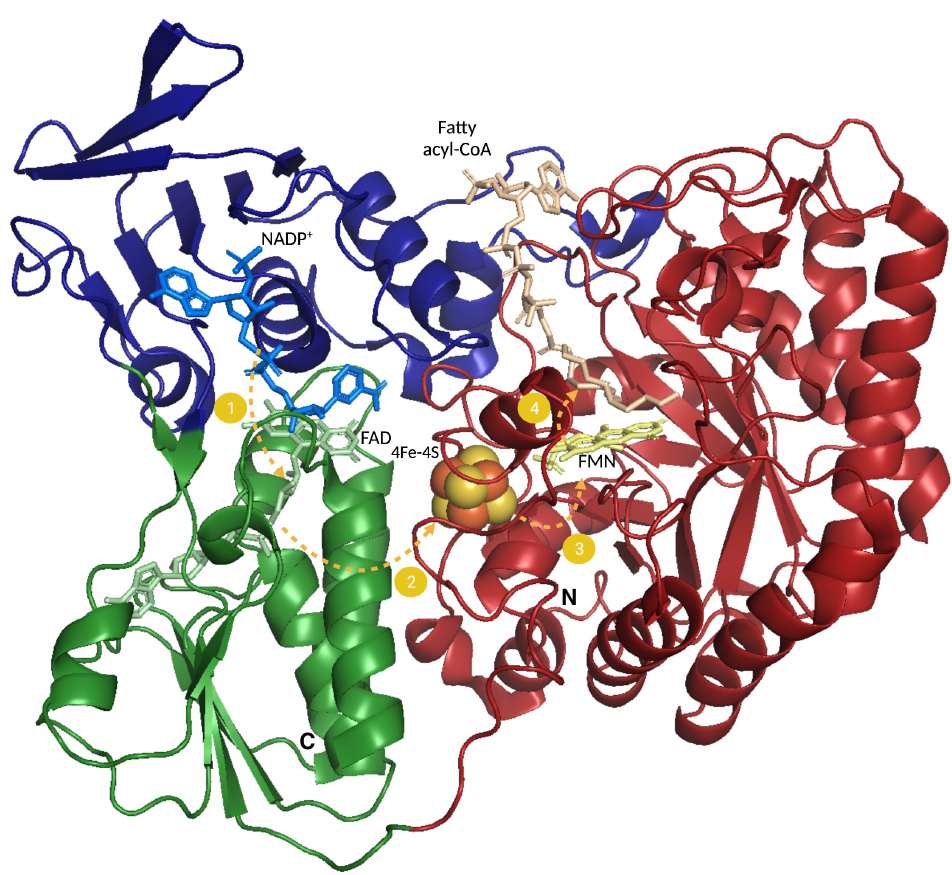
Figure 6. FadH structure. The 3D structure of E. coli FadH determined by X-ray crystallography is shown (PDB code: 1PS9) [35]. The N-terminal TIM barrel is colored in red, with the fatty acyl-CoA substrate in beige and FMN shown as yellow sticks. The [4Fe-4S] cluster is in the center of the figure (yellow and orange balls). The middle flavodoxin-like domain is in green, with FAD drawn as light green sticks. The C-terminal domain is in blue and includes NADPH, shown as light blue sticks. Yellow dashed arrows and numbers correspond to the electron flow during the reduction process from NADPH to the fatty acyl substrate. The N and C termini are indicated. Modified from [35].